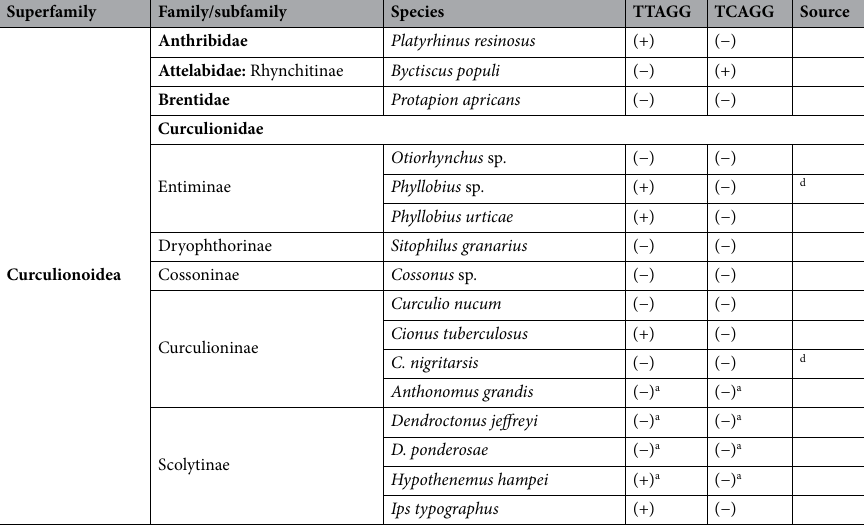
Table 1. A list of coleopteran species tested for the presence of (TTAGG)n and (TCAGG)n species. (+) signal present, (−) signal absent. a Data extracted from Database. b Data from Frydrychova et Marec 20 . c Data from Okazaki et al. 19 . d Data from Mravinac et al. 17 . e Data based on the NCBI and dot-blot